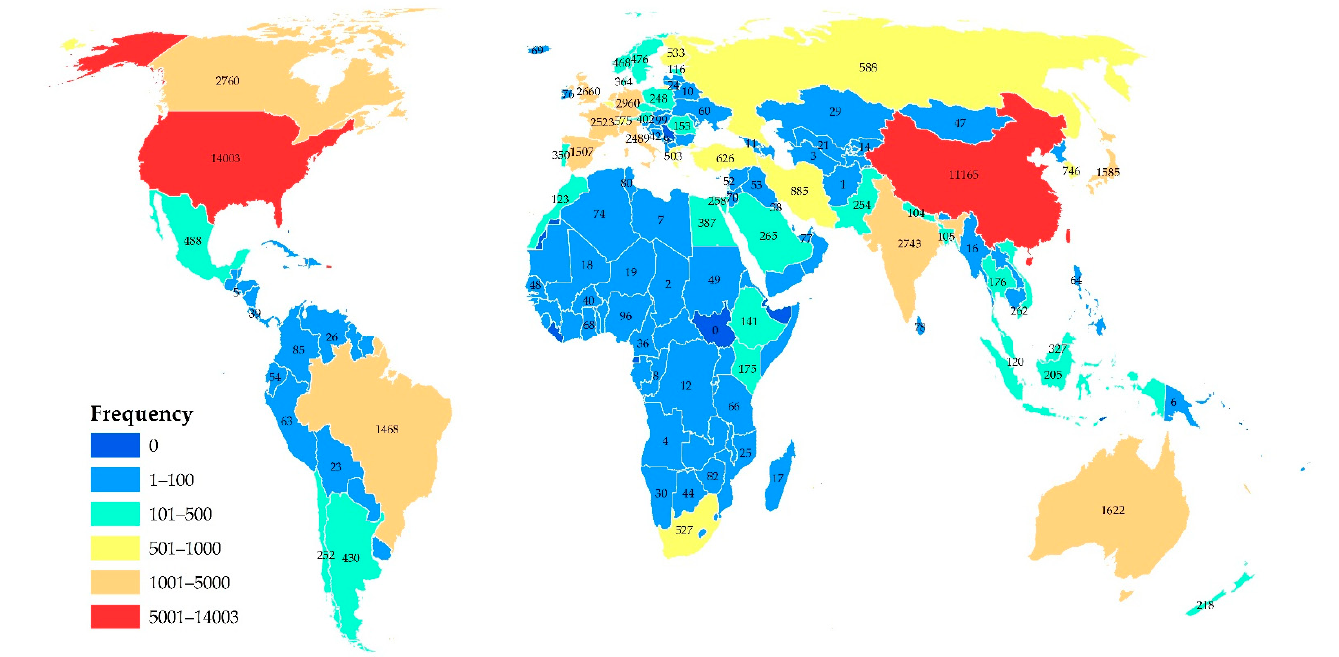
Figure 4. Worldwide distribution of publications referencing EO satellite data.